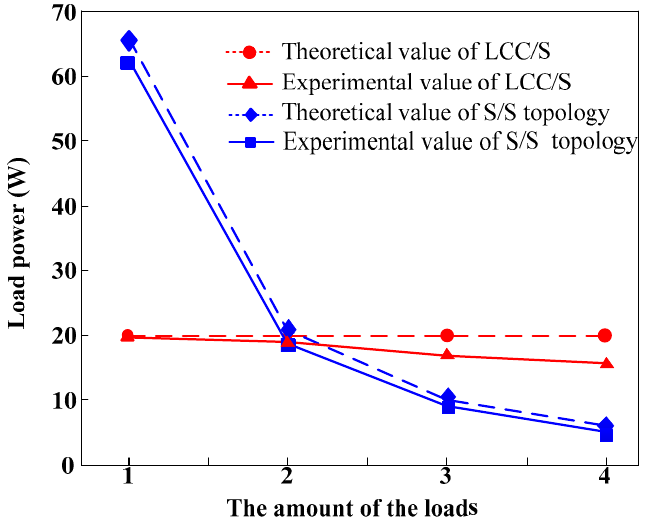
Figure 10. The power received by loads originally existing in the system when the number of loads changes.